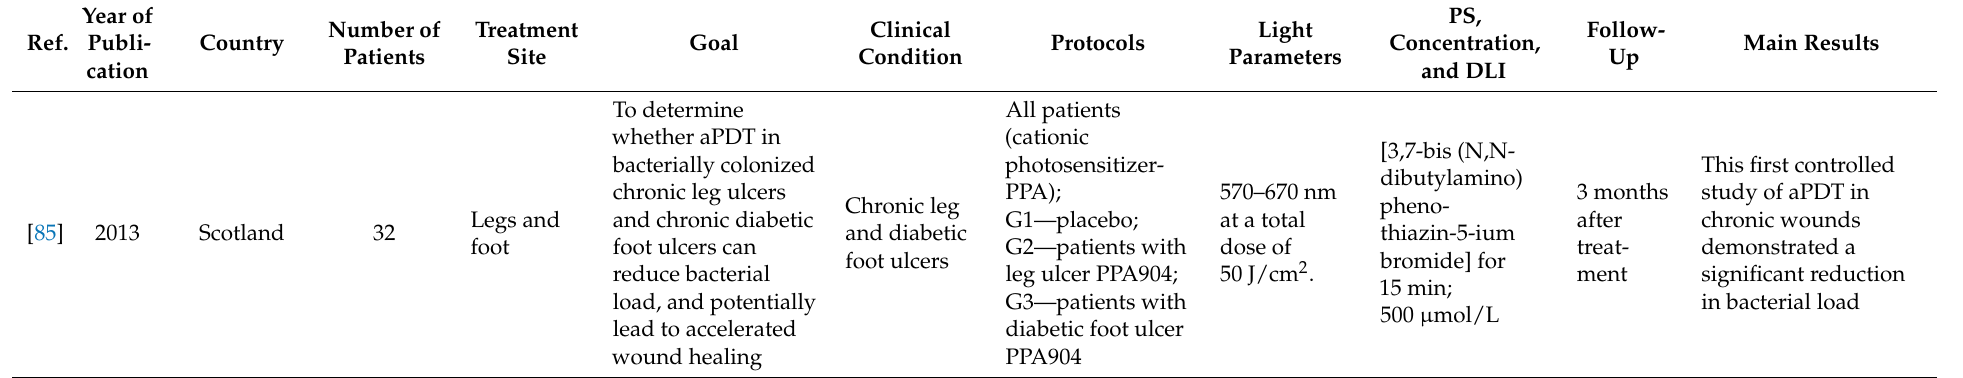
Table 6. Randomized clinical trials that evaluated aPDT for the treatment of ulcers on the skin.